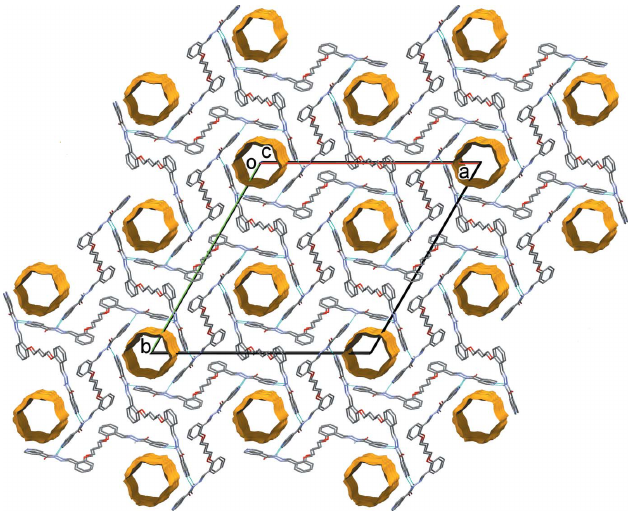
Figure 4 The crystal packing of compound (II), viewed along the c axis. The hydrogen bonds are shown as dashed lines (see Table 4 for details). For clarity, the C-bound H atoms have been omitted. The cylindrical cavities are shown in yellow and brown ( Mercury ; Macrae et al. , 2008).